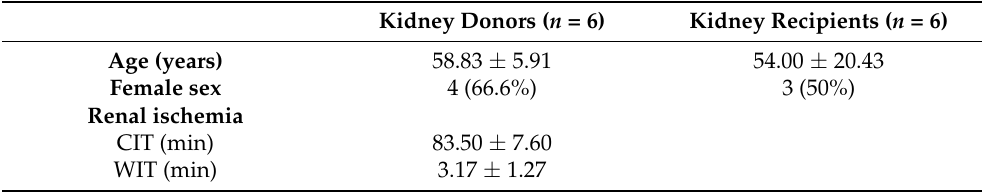
Table 2. Characteristics of KT patients without and with arterial